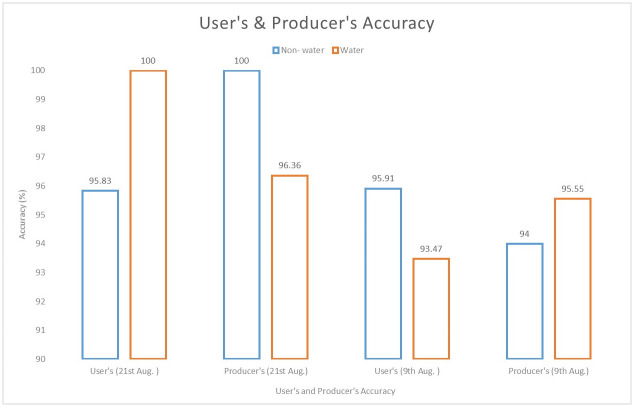
User’s and producer’s accuracy.